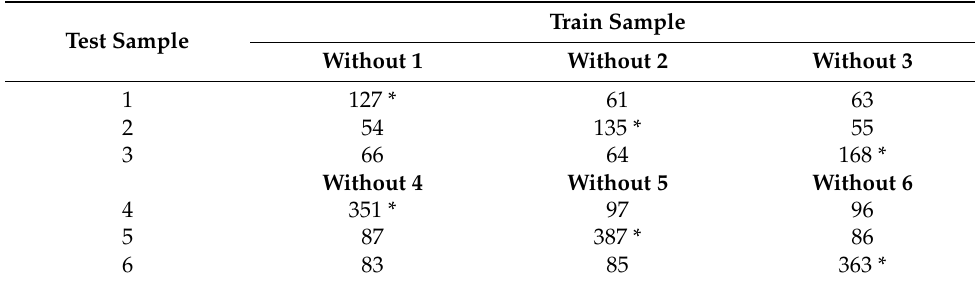
Table 3. Daily mean absolute error in minutes with excluded regions in training.